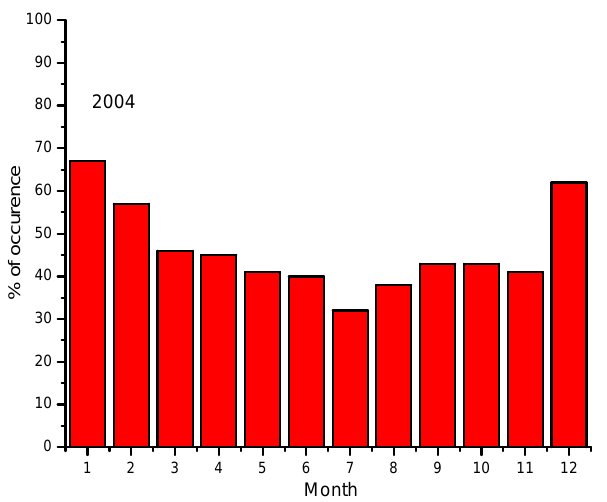
Fig. 2. Monthly mean percentage occurrence of descending inter- mediate layer for solar minimum period 2004 at Waltair.